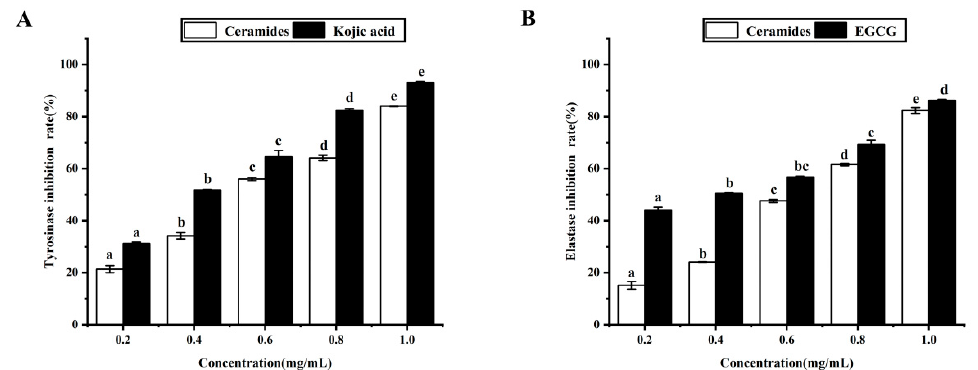
Figure 8. Effects of Cers on ( A ) tyrosinase inhibition and ( B ) elastase inhibition. Varying lowercase letters (a–d) indicate statistically significant differences ( p < 0.05).